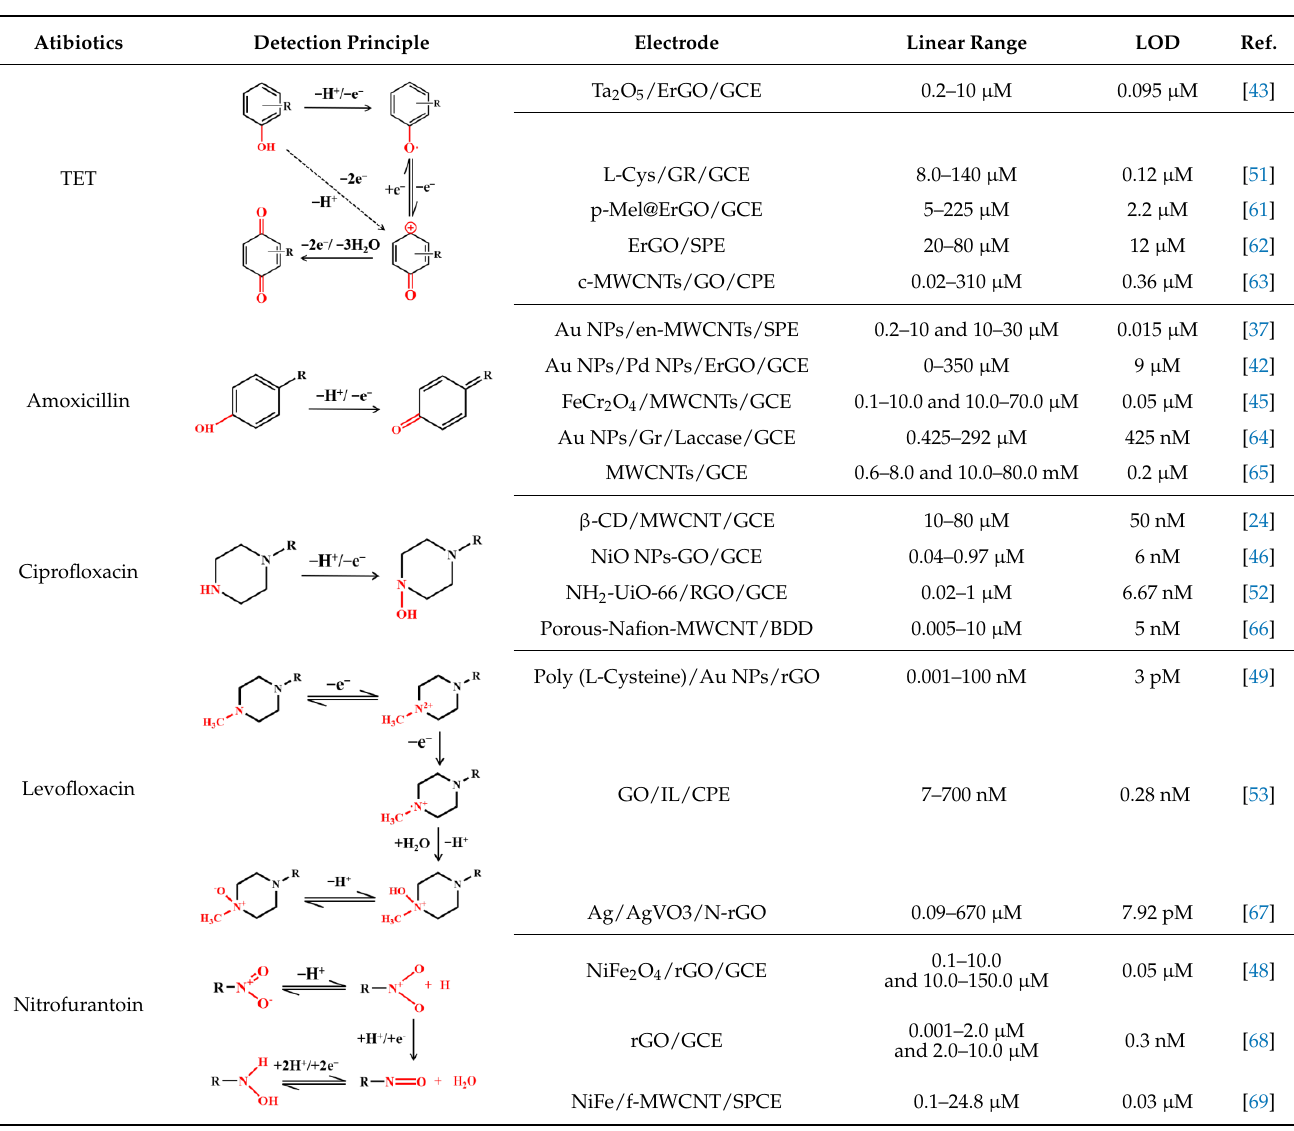
Table 2. CNM-based electrochemical sensor for antibiotics.